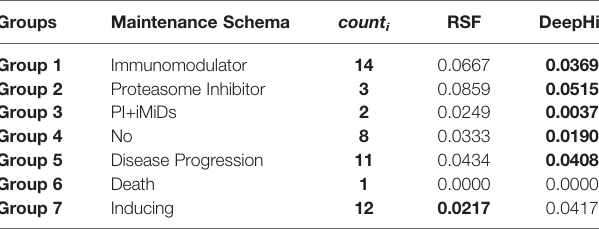
TABLE 1 | Variance of each Maintenance Schema group.